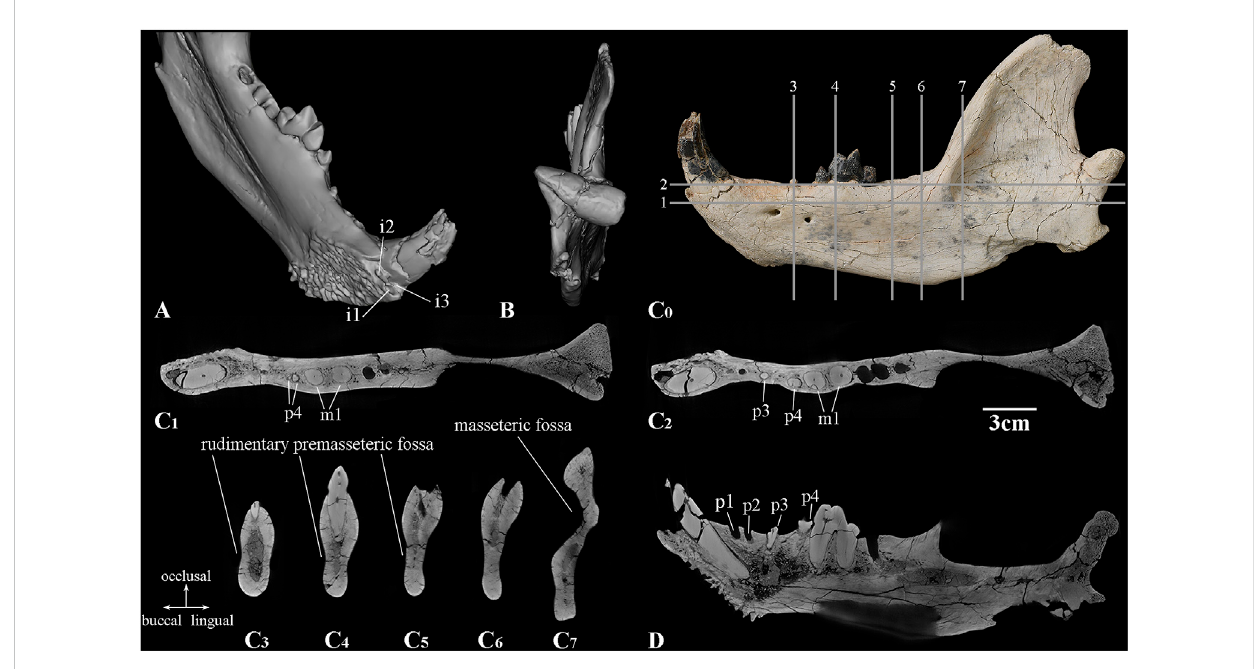
FIGURE 3 CT images of the left lower jaw of Lonchocyon qiui gen. et sp. nov. (IVPP V 28616): (A) dorsolingual view showing the incisors alveoli; (B) posterior view; (C 0 ) lateral view of the lower jaw with the lines showing the positions of horizontal sections in (C 1 , C 2 ) ; cross sections in (C 3 – C 7 ) ; and (D) sagittal section of the lower jaw. Scale bar equals 3 cm for the CT sections.